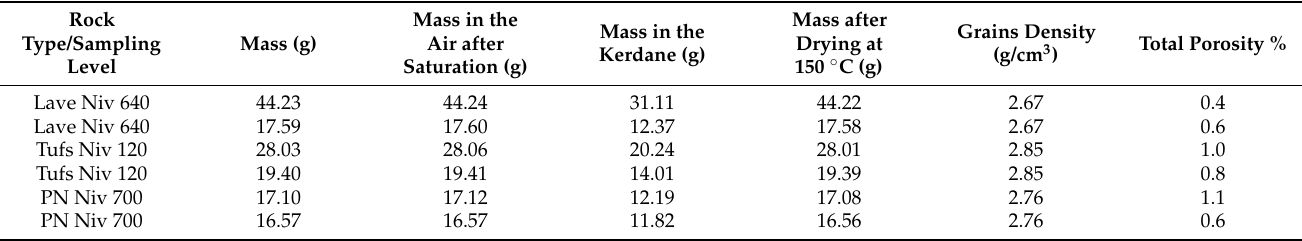
Table 2. Weighing and porosity calculation results.